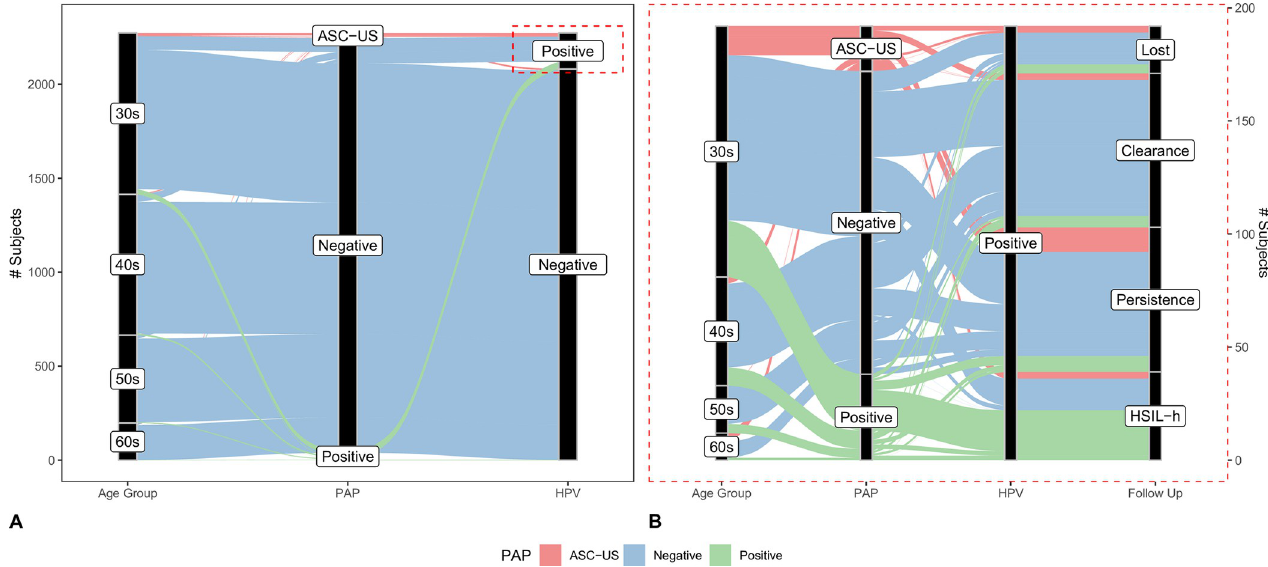
Fig 4. Categorical cohort plot. Cytology (PAP); High-Grade Squamous Intraepithelial Lesion (HSIL) histological-HSIL (HSIL-h). A) Alluvial plot representation of 2,273 patients (lines), where there are three categorical groups in the x-axis (age group, cytology and Human Papillomavirus (HPV)-test results). Within the age group, the subjects are clustered according to the decade strata (the 30s, 40s, 50s or 60s), whereas cytology results use Atypical Squamous Cells of Undetermined Significance (ASC-US), negative or positive strata, and HPV only positive or negative. The Alluvial span, i.e., horizontal x- axis splines are filled by ASC-US, negative and positive cytology results with red, blue, and green, respectively. The vertical axis depicts the cumulative number of subjects. Interestingly, almost all the subjects, regardless of the decade they belonged to, had a negative cytology result with its corresponding negative HPV counterpart in most of the cases. B) The HPV-positive subjects zoom-in (dashed red rectangle in the left panel) with 192 patients. An additional categorical axis includes subject’s follow-up (lost, clearance, persistence or HSIL-h). For easy visualization, the alluvial spans are filled using the follow-up categories. An auxiliary right y-axis was included according to the number of subjects in the zoom-in